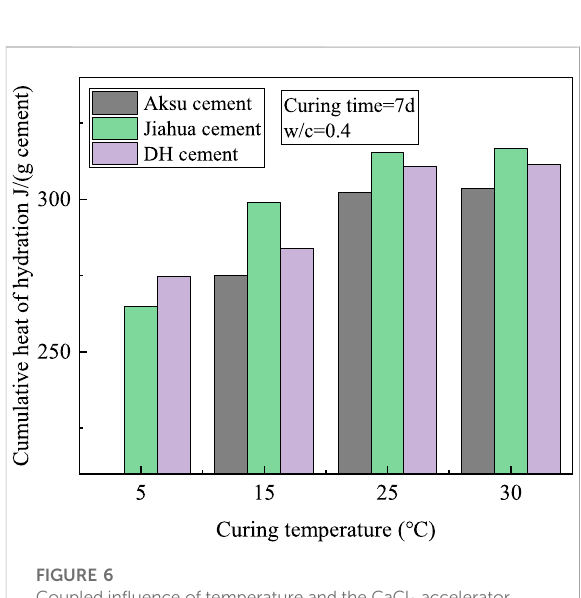
FIGURE 6 Coupled in fl uence of temperature and the CaCl 2 accelerator on cumulative heat (curing time=7 days) for different